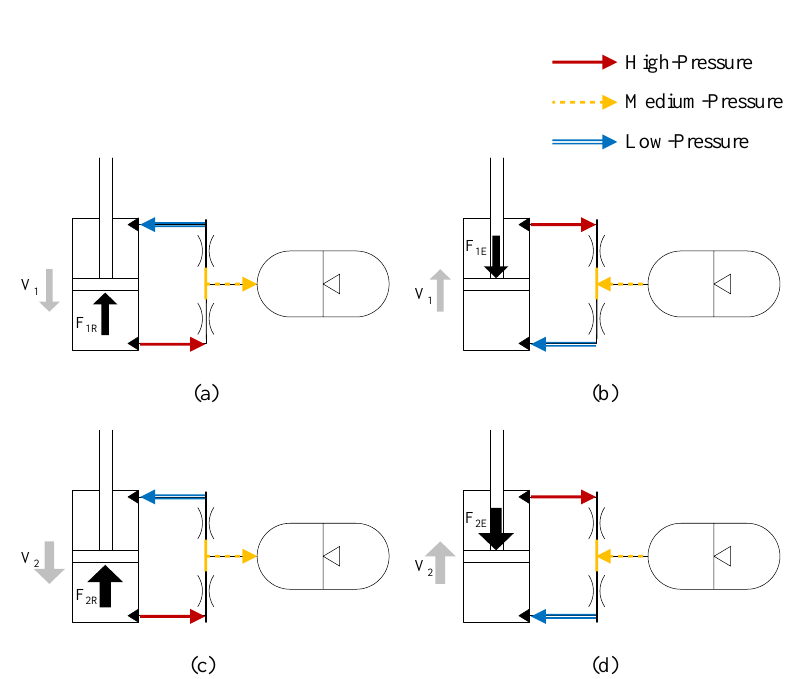
Figure 4. Conceptual diagram of damping force according to velocity change: ( a ) low speed-retraction,